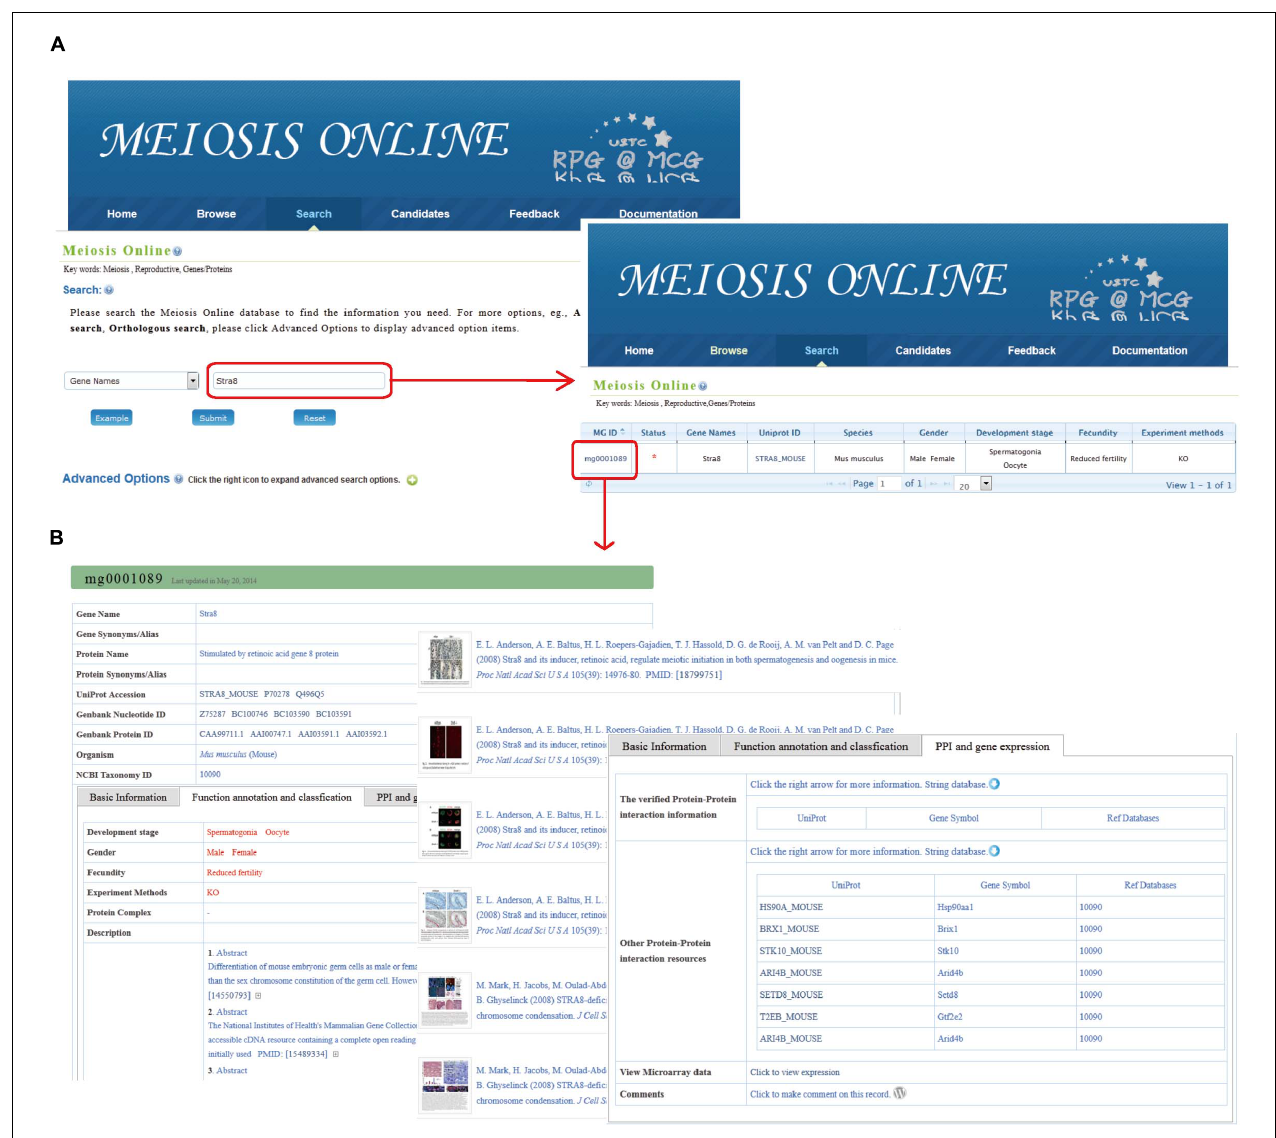
FIGURE 2 | The search function of MeiosisOnline. (A) Users can simply input gene “ Stra8 ” for querying. The results are shown in a tabular format. Users can visualize the detailed information by clicking on the MeiosisOnline ID (MG0001089). (B) The detailed information for mouse gene “ Stra8 .” The information presented has been manual checked and will be updated based on newly published